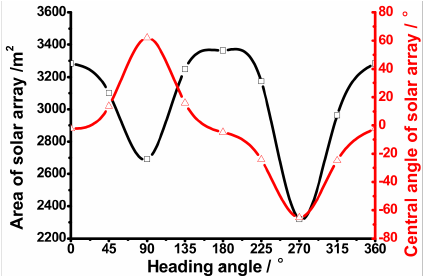
Figure 18. The optimized area and central angles of solar arrays for different heading angles.